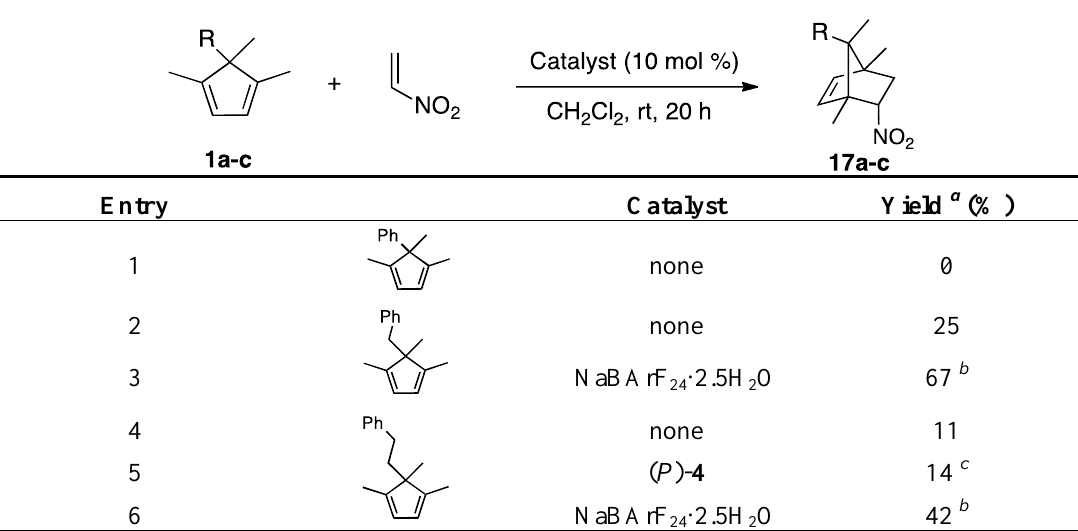
Table 4. Evaluation of new